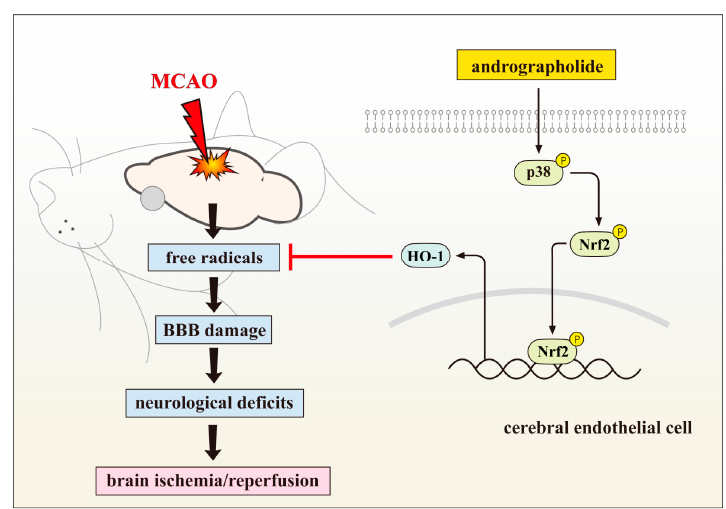
Figure 1. Andrographolide expressively suppressed free radical formation, blood-brain barrier (BBB) disruption, and brain infarction in middle cerebral artery occlusion (MCAO)-insulted rats. The mechanism of this effect was attributable to HO-1 activation. From this study, it is established that andrographolide provides protection against MCAO-induced brain ischemic injury via increased Nrf2-HO-1 expression through p38MAPK regulation.